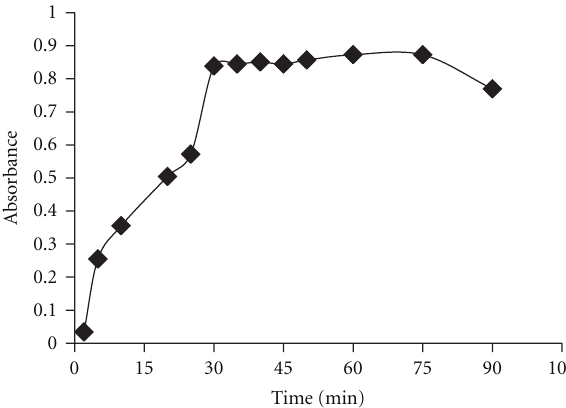
Figure 2: Study of reaction time between NBS and OXC in sulphuric acid medium and stability of the coloured species by measuring the absorbance of the unreacted BPR after reacting with